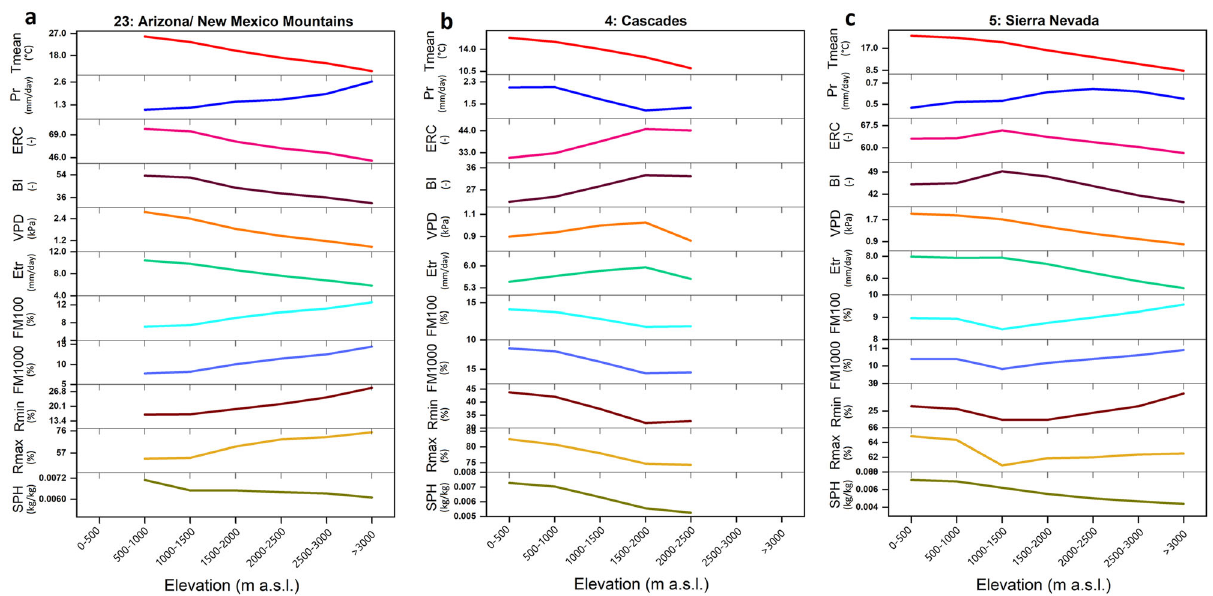
Fig. 3 | Elevational changes in the climatology ofmeteorological variables and fi re danger indices. Average warm-season values of mean daily temperature (Tmean), precipitation (Pr), energy release component (ERC), burning index (BI), vapor pressure de fi cit (VPD), daily reference evapotranspiration (based on alfalfa; Etr), 100-h and 1000-h dead fuel moisture (FM100 and FM1000, respectively),